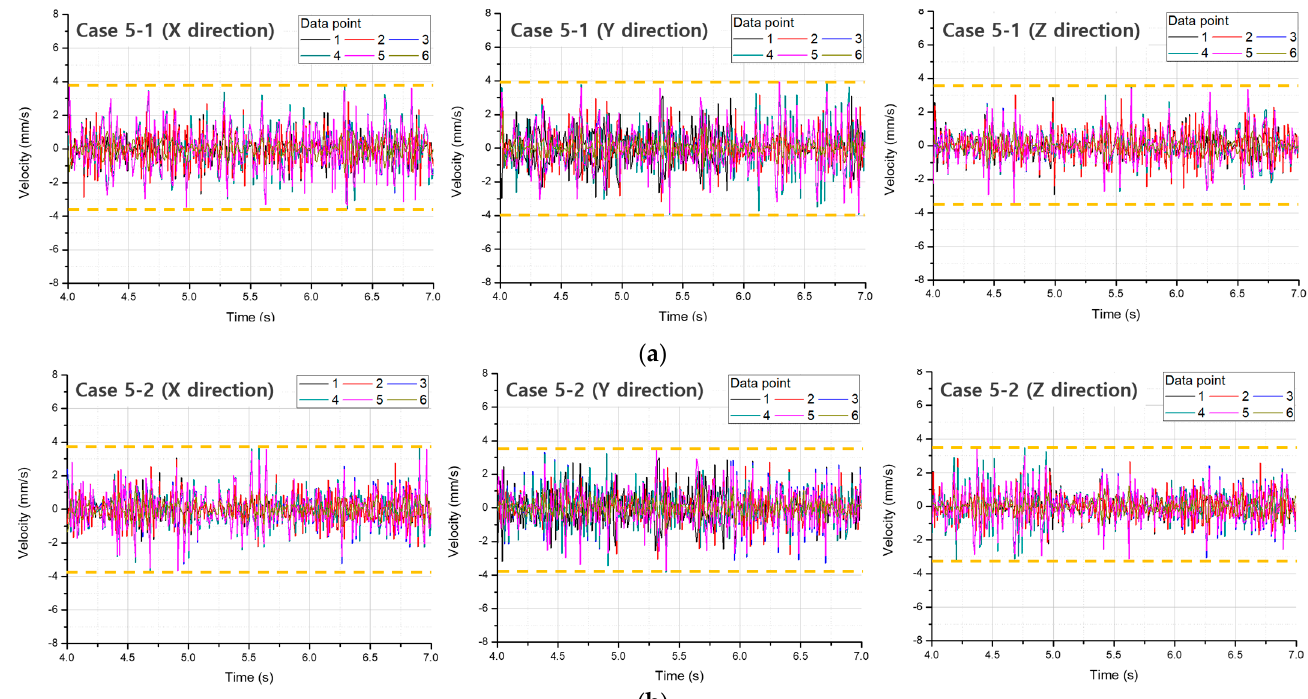
Figure 13. Vibration velocity based on the axial direction: ( a ) Case 5-1; ( b ) Case 5-2. Table 8. Vibration velocity data according to design change.